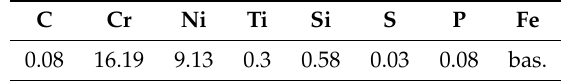
Table 1. Chemical composition (wt. %) of the austenitic steel under